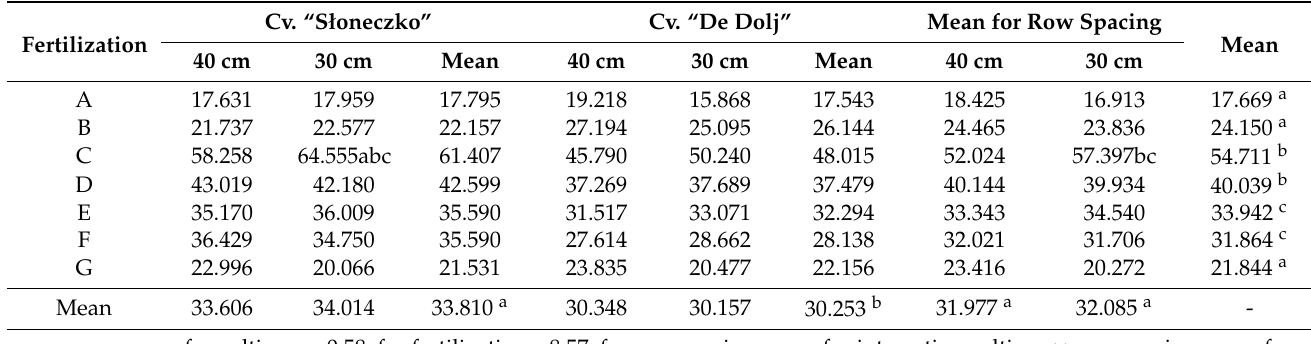
Table 6. Flavonoid content in thyme raw material (mg CA 100 g − 1